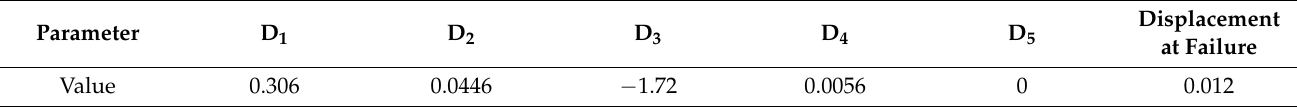
Table 2. Johnson–Cook damage model parameters for AA5052 for damage evolution.